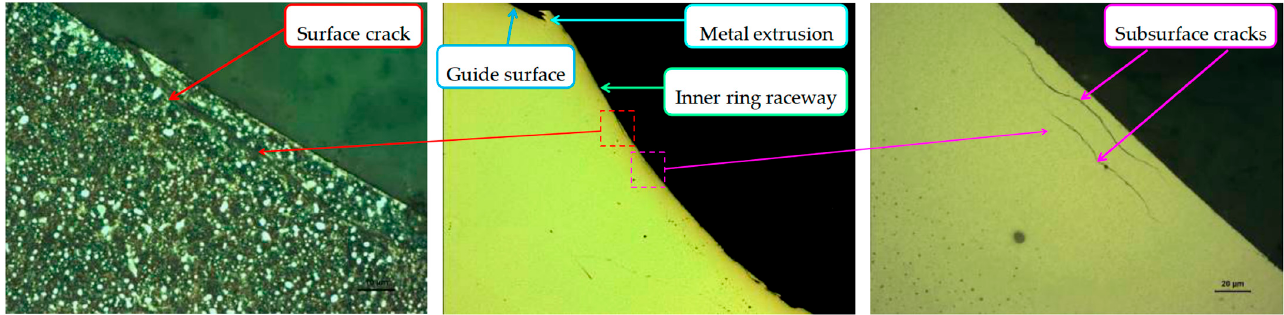
Figure 10. Microstructure, cracks and metal extrusion of the inner ring raceway.